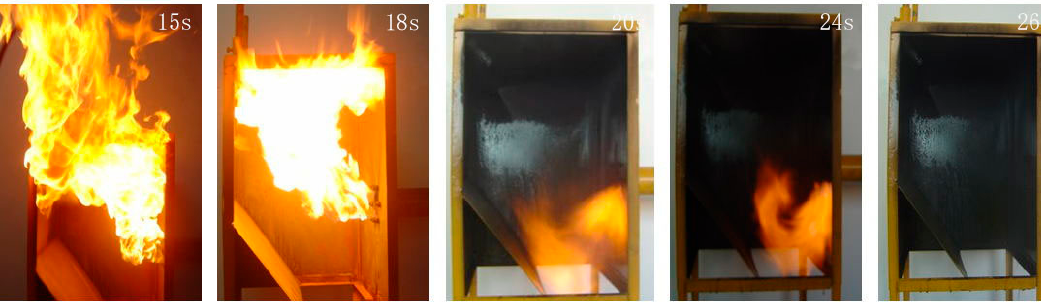
Figure 12. Experimental images of the drilling hole gas flame suppressed by water mist.